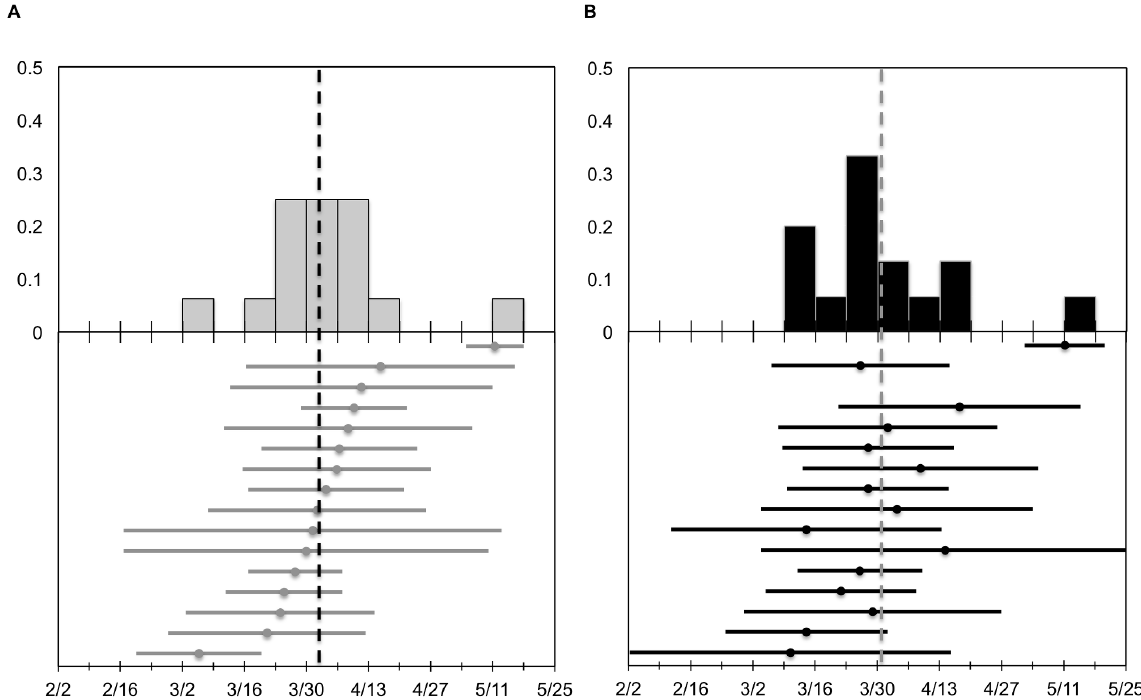
Figure 3. The midpoint and duration of migration in spring 2011 for 16 adult mallard hens. Upper panes illustrate the frequency distribution for the midpoint of spring migration according to (a) geopolitical method and (b) ND approach. Lower panes illustrate corresponding migration midpoints (circles) and extents (bars) for each of the methods. Vertical dashed lines represent the mean migration midpoint.